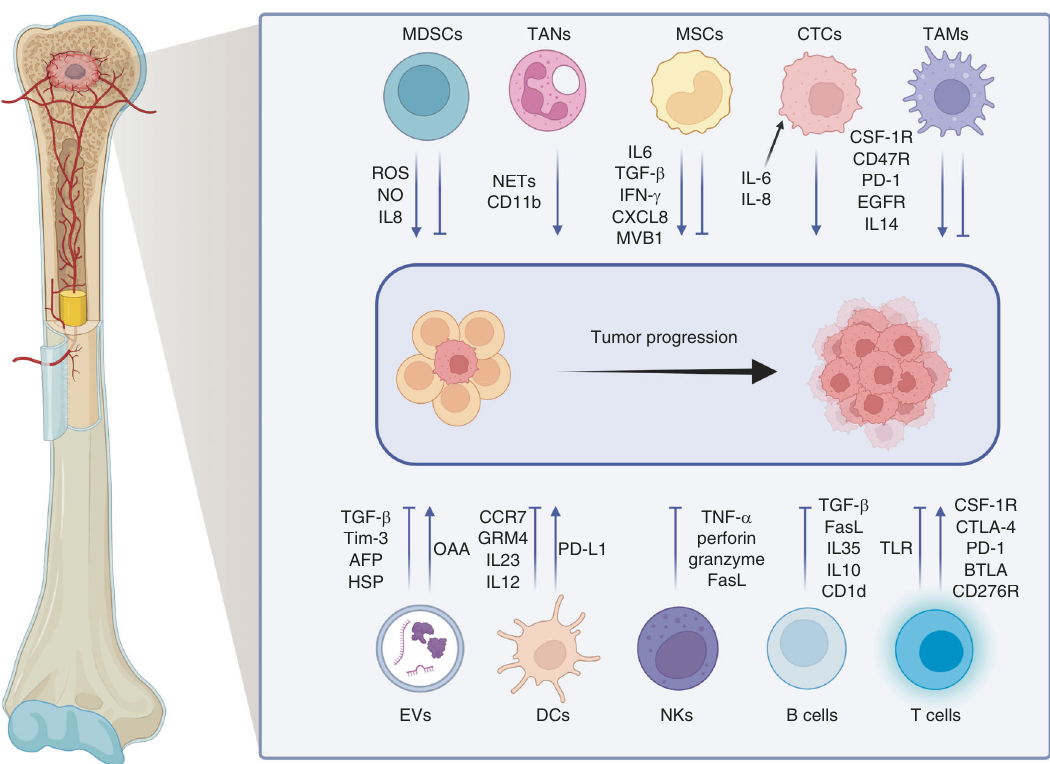
Fig. 2 The components in the immune microenvironment of osteosarcoma and the mechanisms of their protumor and antitumor